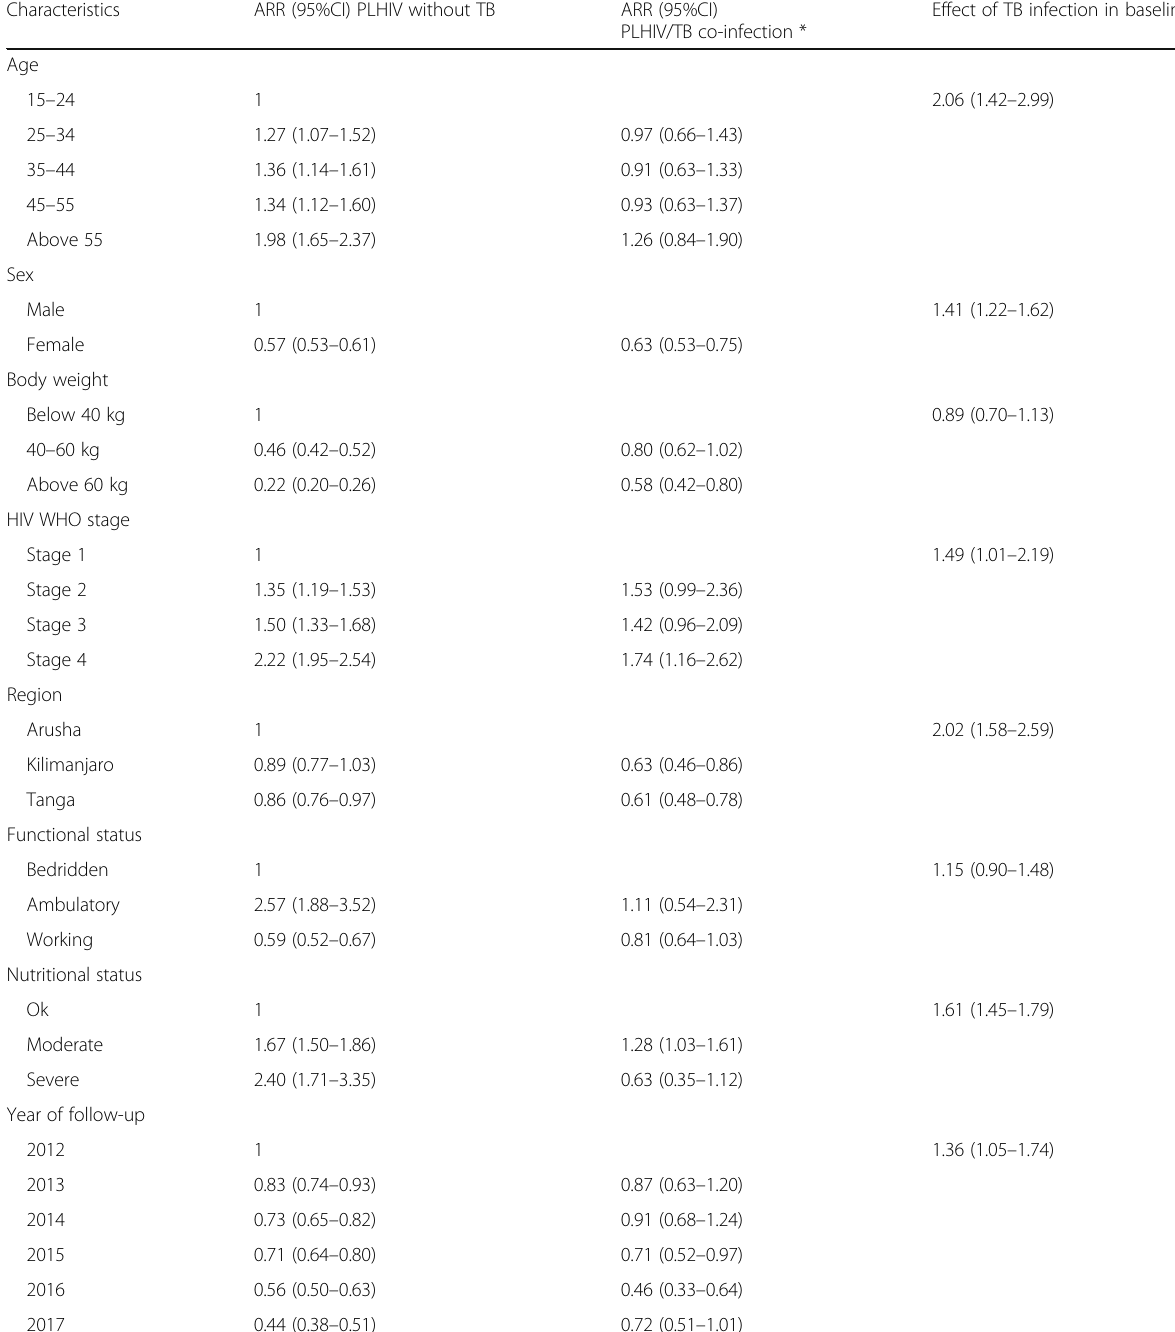
Table 4 Poisson regression with multilevel analysis, with health facility as cluster variable in Northern Tanzania. Interaction effects for mortality among patients with HIV adjusted for the significant effects included in Table 3 ( N =